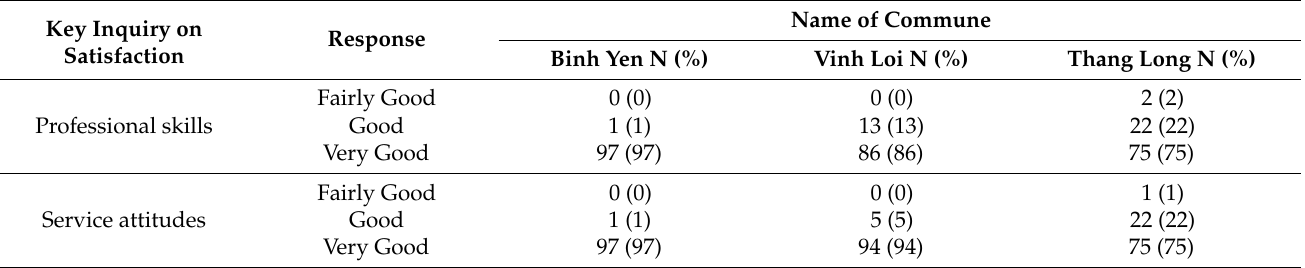
Table 5. Participants’ satisfaction with professional skills/service attitudes of CHS medical